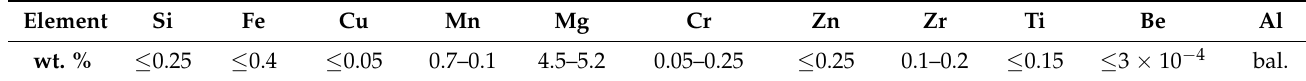
Table 3. Chemical composition of the 5087 aluminum filler material.